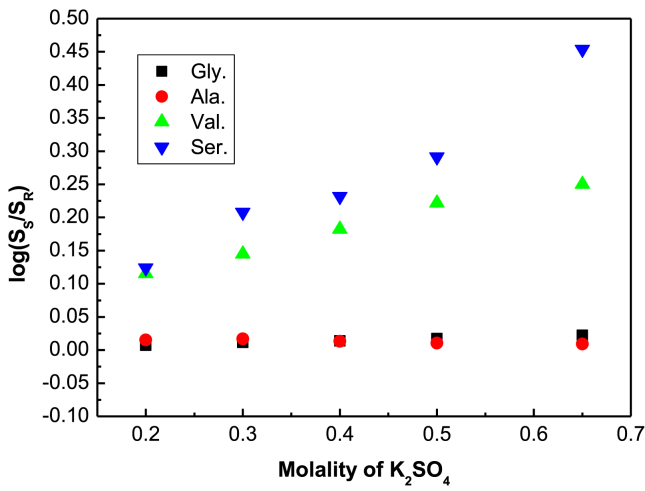
Logarithm of the ratio of solubilities SS with and SR without electrolytes for glycine (■), D,L-alanine (●),D,L-serine (▼) and D,L-nor-valine (▲) with the molality of K2SO4 in aqueous K2SO4 solution at 298.15 K.